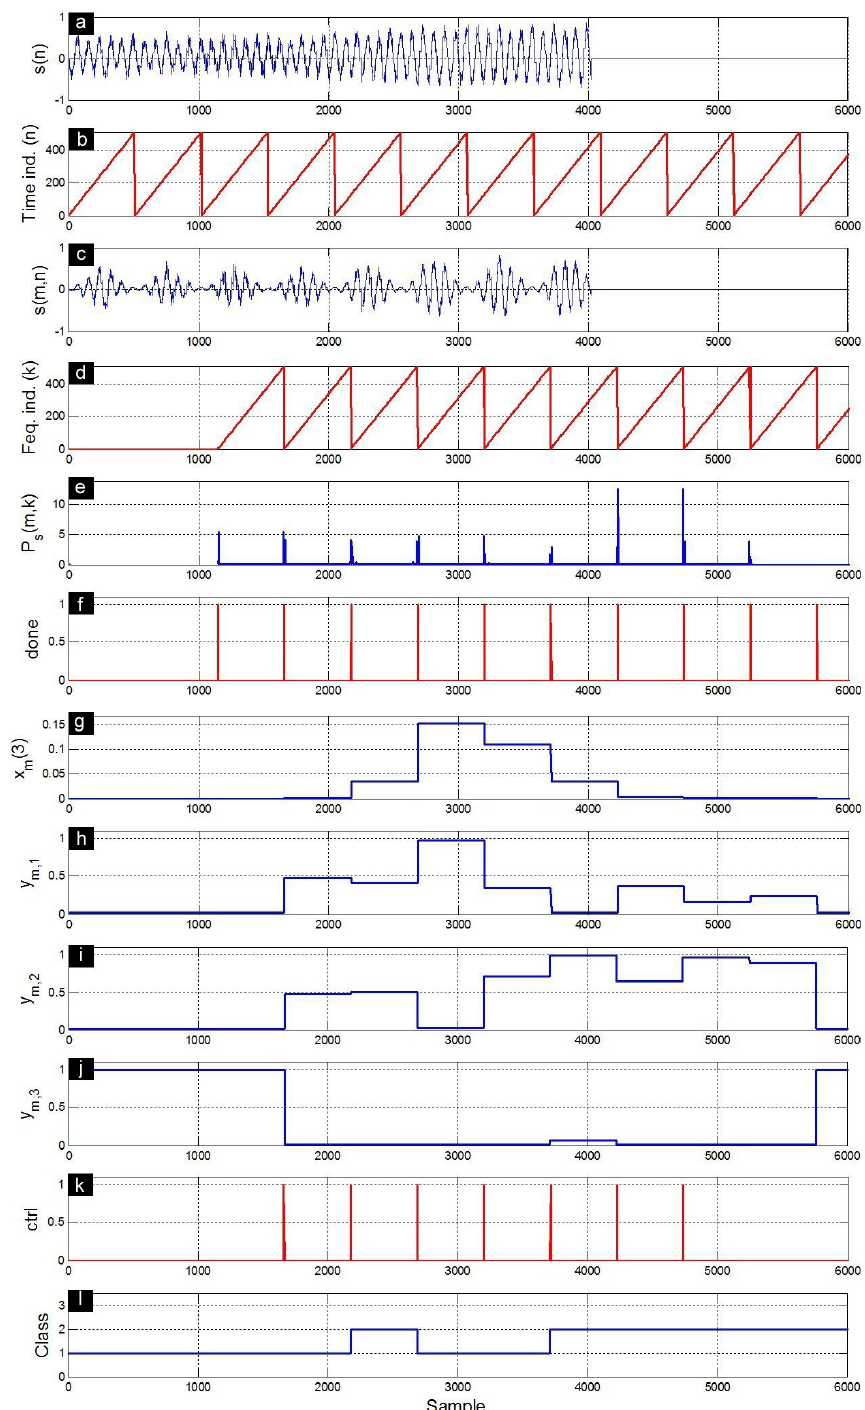
Figure 10. Response signals obtained during the characterization/classification of a B call. ( a ) input signal s ( n ) ; ( b ) time index n that allows to delimit successive frames s ( m , n ) ; ( c ) windowed signal s ( m , n ) ; ( d ) frequency index k that allows to delimit successive power spectra; ( e ) power spectra P s ( m , k ) ; ( f ) done signal; ( g ) third component of the feature vector x m ( 3 ) ; ( h ) first MLP output y m ,1 ; ( i ) second MLP output y m ,2 ; ( j ) third MLP output y m ,3 ; ( k ) ctrl signal; and ( l ) recognized